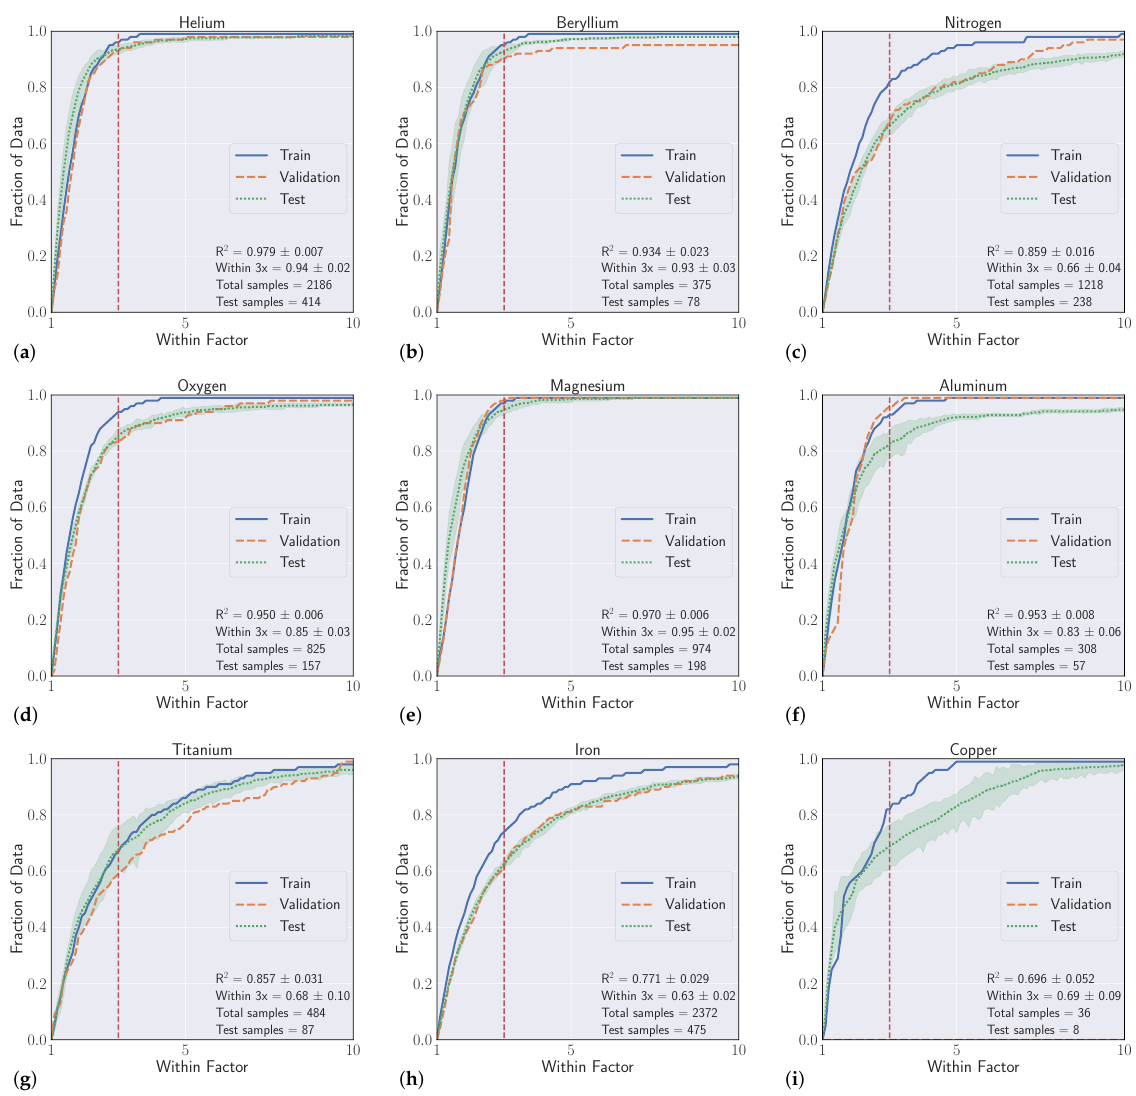
Figure 7. Performance of interelement models showing fraction of transition probability predictions within a factor of the published value for training, validation, and testing sets. Table 3. Quantitative performance metrics for intraelement and interelement